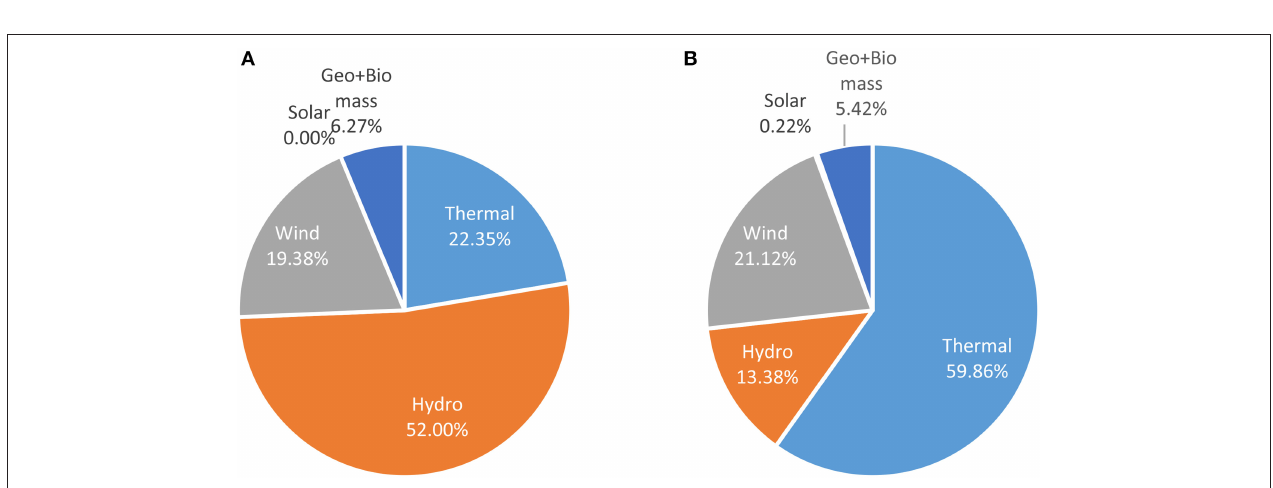
FIGURE 8 | Environmental conflicts against the HPPs, Turkish Map of Environmental Justice, March 2017 .